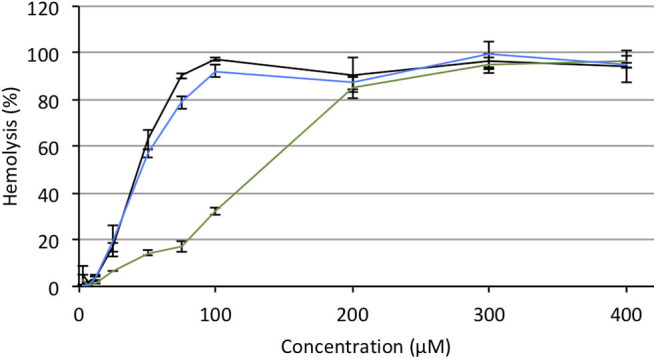
Hemolytic effect of miltefosine (black), perifosine (blue), and erufosine (green) on sheep RBC incubated at 37°C for 1 h, as a function of the APL concentration.